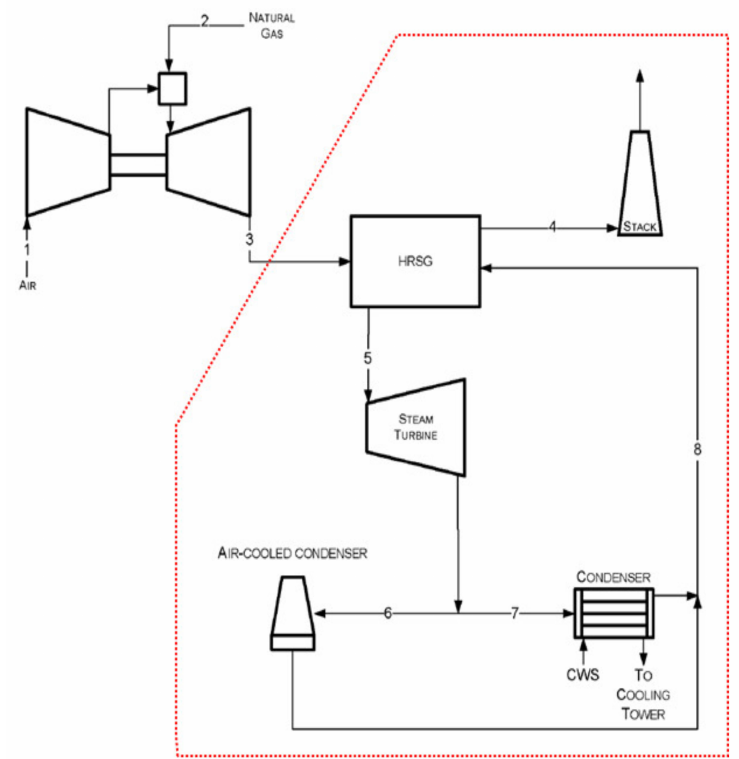
Figure 5. Simplified back flow diagram (BFD) of the Natural Gas Combined Cycle (NGCC) system and target boundary in the S31A case